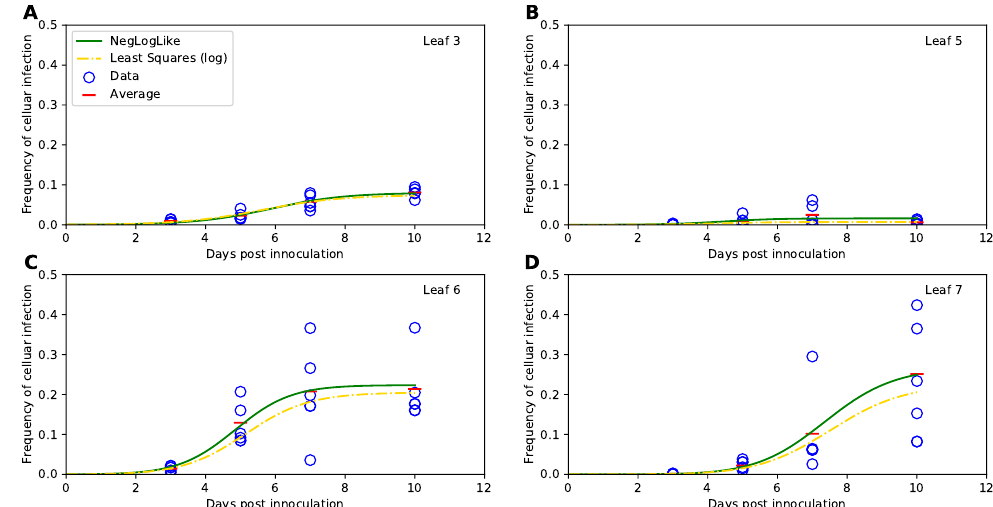
Figure 4. Best fits of the basic mathematical model found using either binomial distribution-based likelihood or least squares are nearly identical. We used either binomial distribution-based likelihood method (Equation (29), [14]) or least squares for log-transformation of the data and model predictions (Equation (35)) to fit the basic mathematical model (Equations (1)–(3)) to the virus spread data for leaf 3 ( A ), leaf 5 ( B ), leaf 6 ( C ) and leaf 7 ( D ). Data on proportion of virus-infected cells are shown by markers and lines are the predictions of best fit models. Parameters for the model fit using likelihood and least squares with the log transform are given in Table 1 (“New parameters ( nll )” and “New parameters ( Log LS )” columns, respectively). In fitting the models using least squares for log-transformed data, the limit of detection (LOD) was LOD = 5.12 × 10 − 4